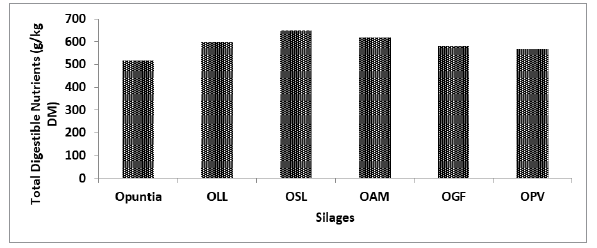
Effect of silages on total digestible nutrients (g/kg dry matter).